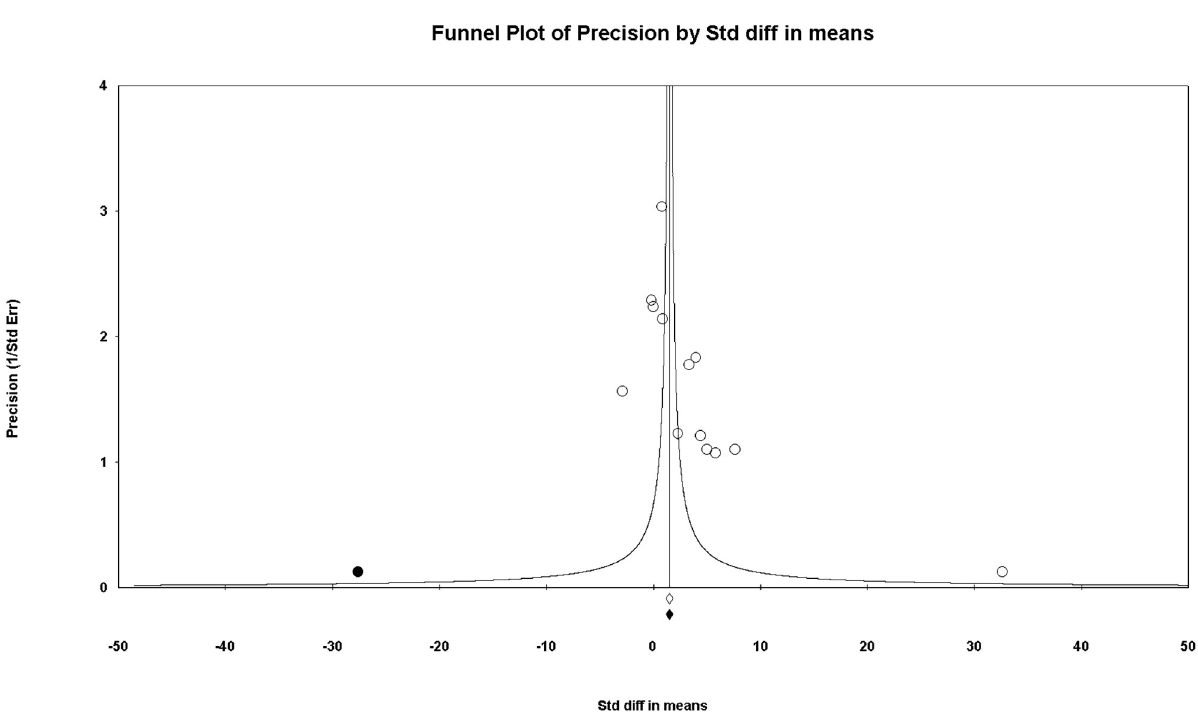
Fig 9. Funnel plot of comparison: Methylene blue compared with combined results of using saline and nothing as control; outcome— macroscopic adhesion score. White circles: included comparisons. Black circles: imputed comparisons using the trim-and-fill method. White diamond: pooled observed log risk ratio. Black diamond: pooled imputed log risk ratio.